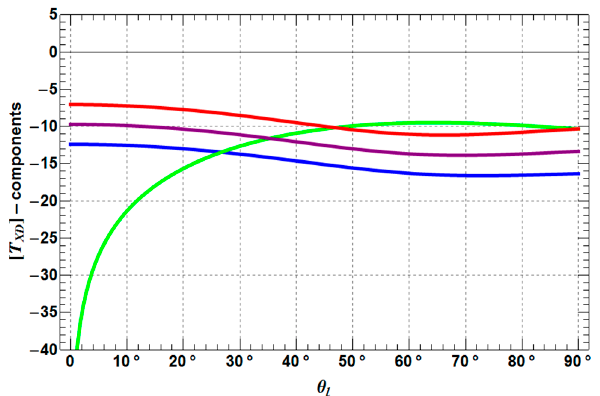
Figure 2. Sensitivity of coherency matrix elements T XD11 (blue), T XD12 (purple), T XD22 (red) and T XD33 (green) (dB) with roughness angle θ 1 ( ε s = 20, ε t = 10, ω l = 30°, L SXD = 1, ϕ = 0°).